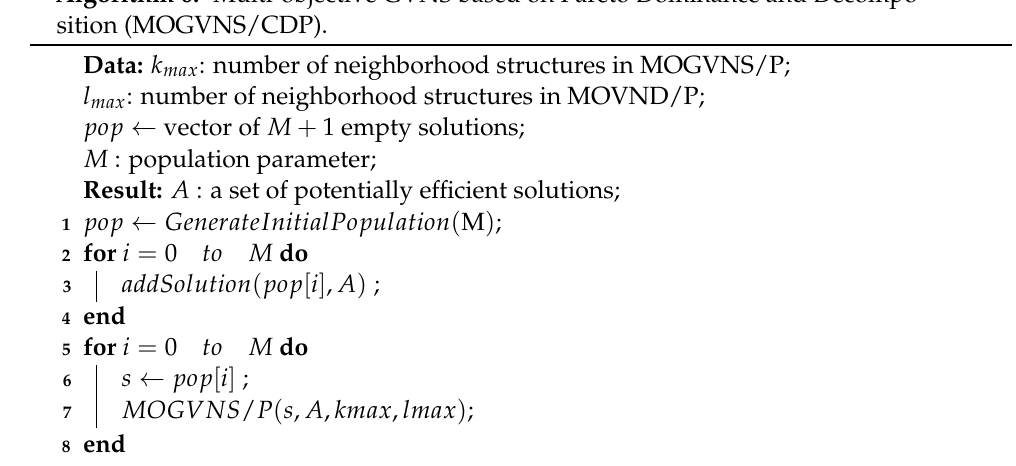
Algorithm 7 combines the general structure of the classical aggregation-based method, decomposition algorithms, and GVNS algorithm. It divides the multi-objective problem into M + 1 mono-objective problems based on aggregation through different weight